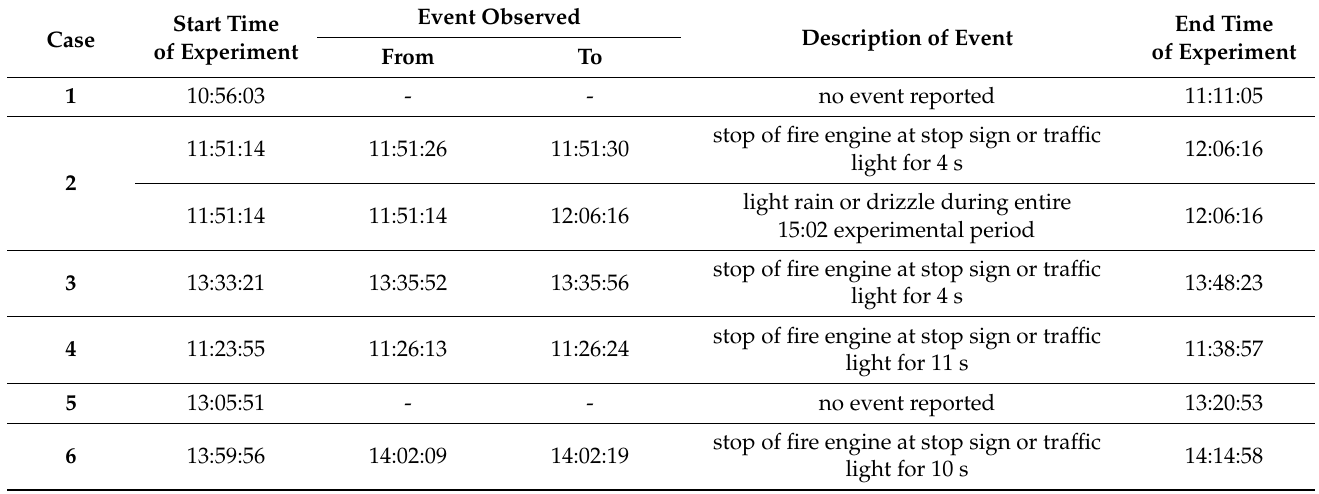
Table 3. Changes of environmental conditions and events non-compliant to the study